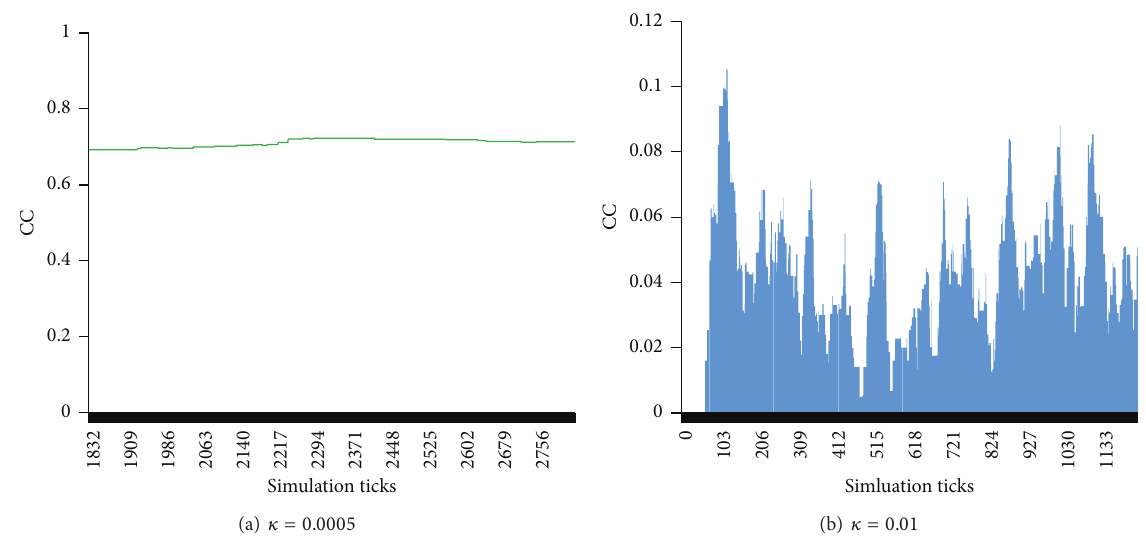
Figure 4: The global clustering coefficient with different values of the parameter 𝜅 , where 𝛼 = 5 , 𝛽 = 10 , 𝑚 = 5 , 𝑝 1 = 1 , and 𝜆 = 0.3 .